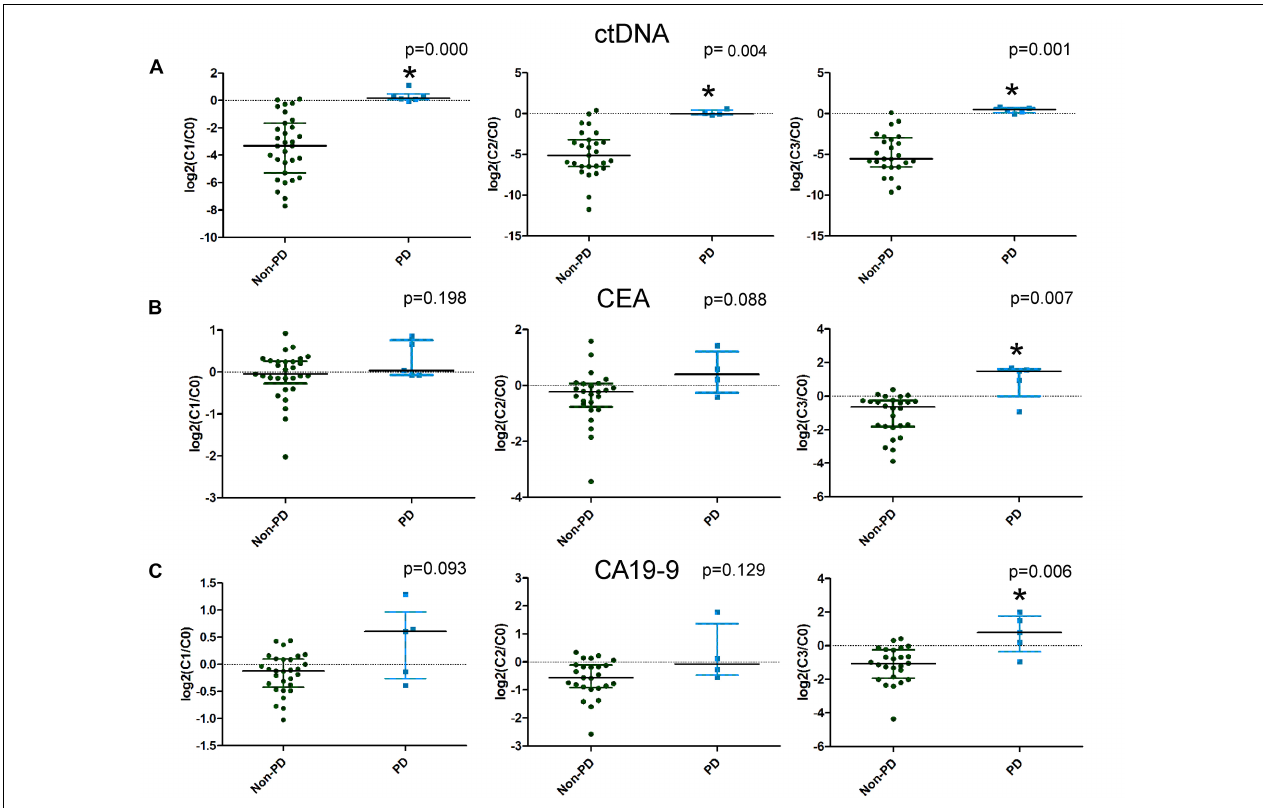
FIGURE 3 | The differences in the changes in circulating tumor DNA (ctDNA), carcinoembryonic antigen (CEA), and carbohydrate antigen 19-9 (CA19-9) levels between progressive disease (PD) and non-PD patients. Changes in ctDNA, CEA, and CA19-9 levels after the first, second, and third cycles of treatment are illustrated in A–C , respectively. TABLE 1 | Predictive values of the changes in ctDNA, CEA, and CA19-9 levels for the imaging responses of progression disease. Cutoff Sensitivity (%) Specificity (%) PPV (%) NPV (%) Accuracy